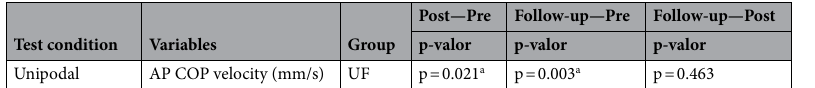
Table 3. Post-hoc analysis between time-points. Post-hoc analyses were executed running Wilcoxon-sign ranked tests between the different time points. AP : Anteroposterior; COP : Centre of Pressure; I : Impact effect size; UF : Unstable footwear. a Statistically significant difference (p <